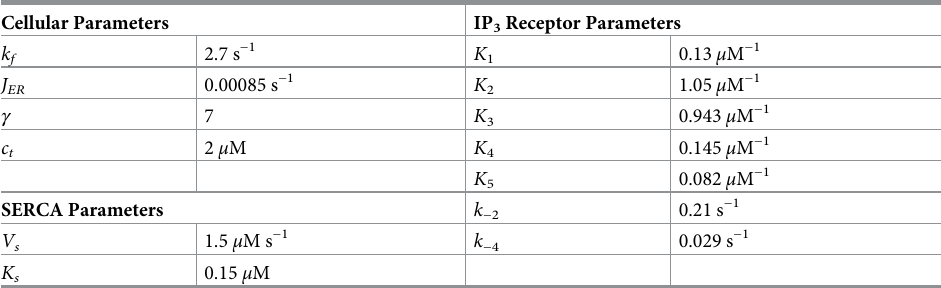
Table 1. Parameter values of the closed-cell Ca 2+ base model. All IP 3 R parameters were adopted from De Young and Keizer (1992) while the Cellular and SERCA parameters were altered to match experimental results. Cellular